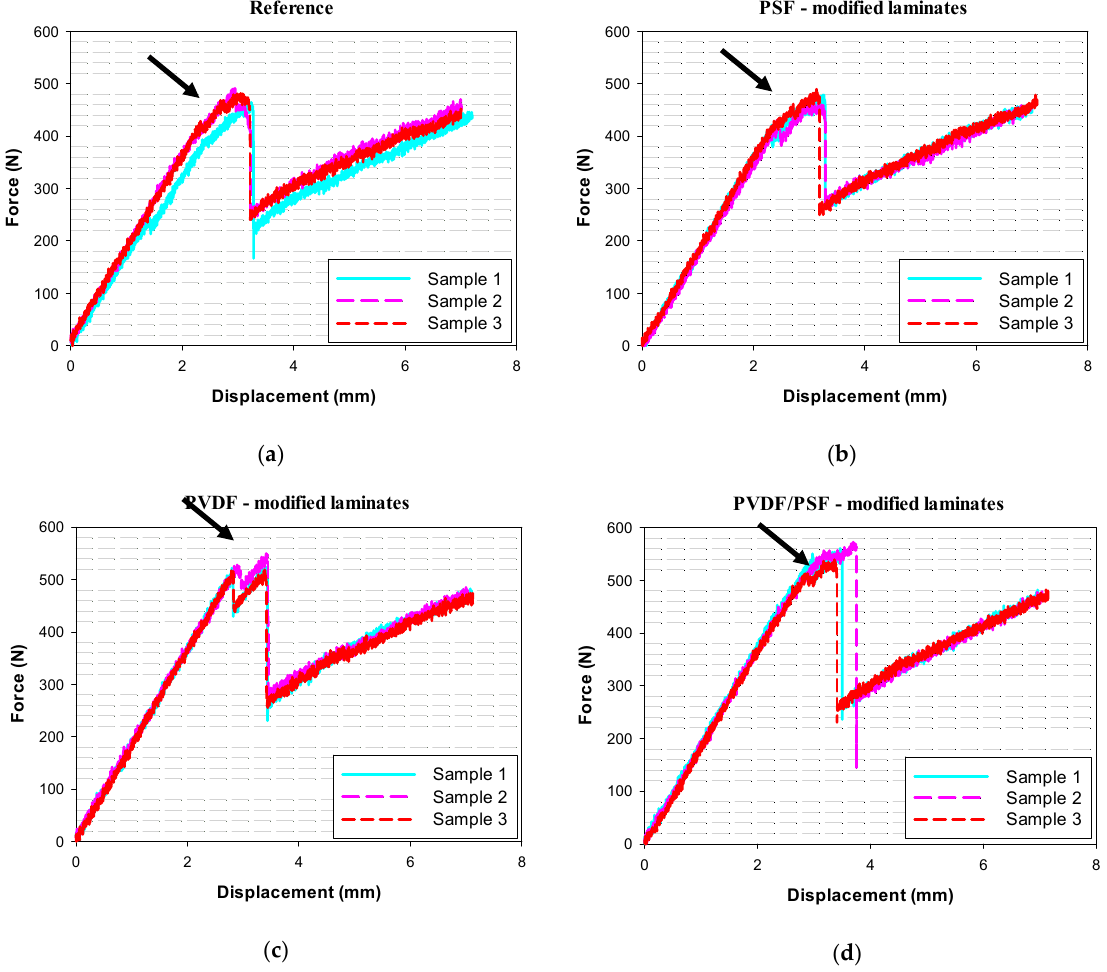
Figure 6. Mode ‐ II fracture test (ENF) outcomes for reference ( a ), PSF ‐ only ( b ), PVDF ‐ only ( c ) and